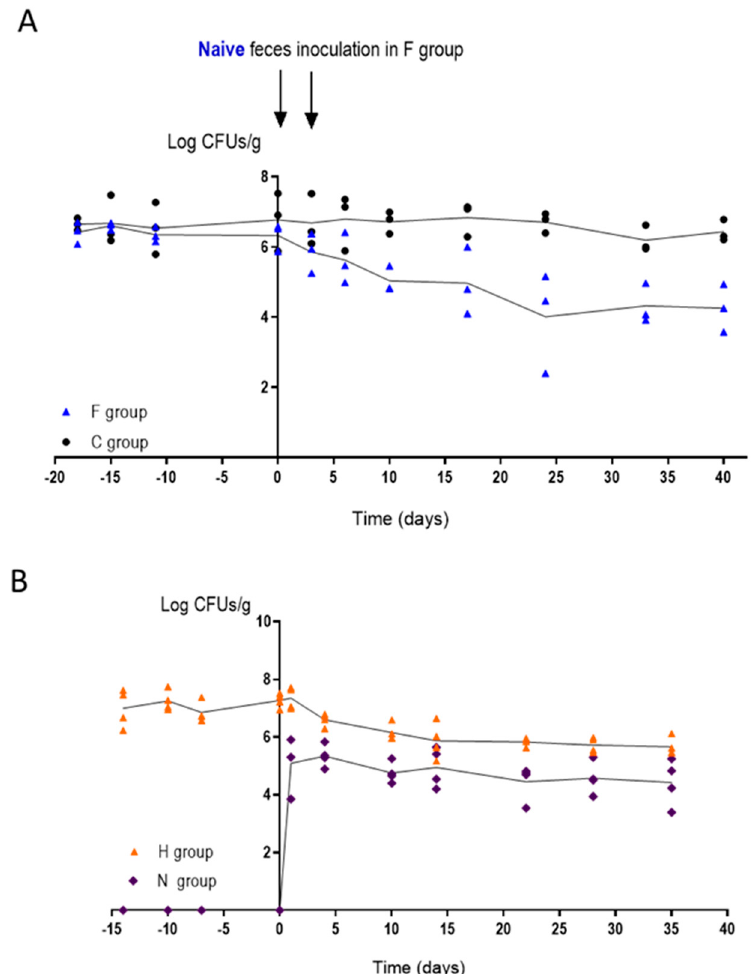
Figure 6. Influence of the microbiota in mice stably colonized with CaORAL3 strain and without antibiotic treatment for 30 days. ( A ) Feces from naïve mice was inoculated in F group and colonization load was followed in time. Group C was followed as control. ( B ) Naïve mice (N group) were introduced in the cage of mice previously colonized by CaORAL3 (H group) and colonization load was followed in time. Results of two independent assays are shown in the graph.